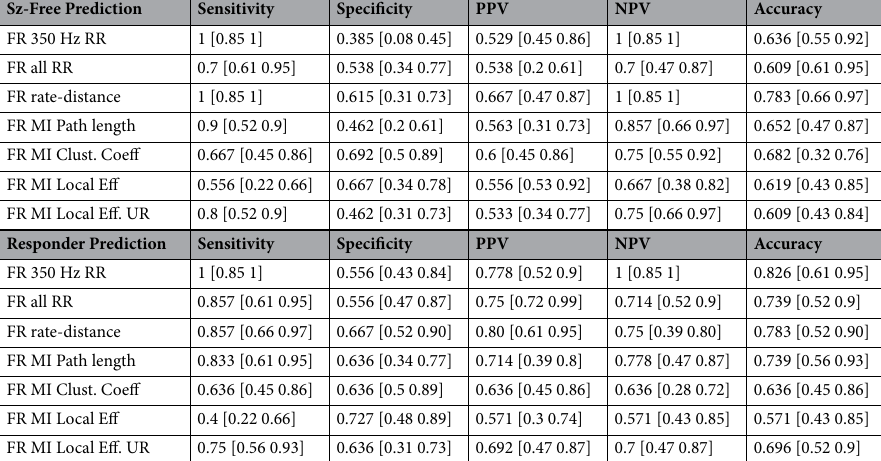
Table 1. Metrics of the confusion matrices derived from each of the fast ripple (FR) resection measures at Youden’s J of the respective receiver operating charecteristic (ROC) curves for predicting post-operative seizure free outcome (top) and improvement in seizures (bottom). Brackets indicate the 95% confidence interval. For the patients without FR mutual information (MI) networks, (i.e., indeterminate) confusion matrices values were imputed appropriately (see supplementary